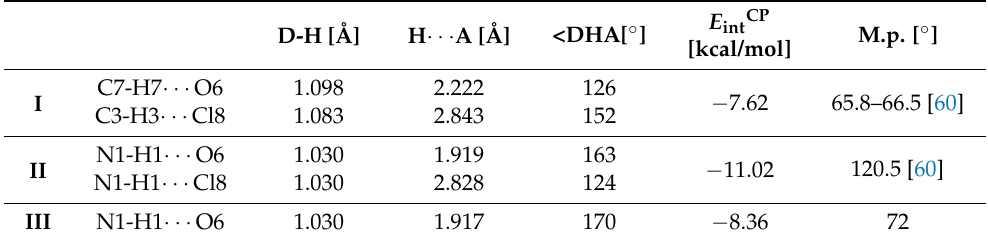
Table 1. Selected geometric parameters and energy of interactions for two interacting molecules in crystal obtained at the ω B97XD/G-311++G(d,p) level of